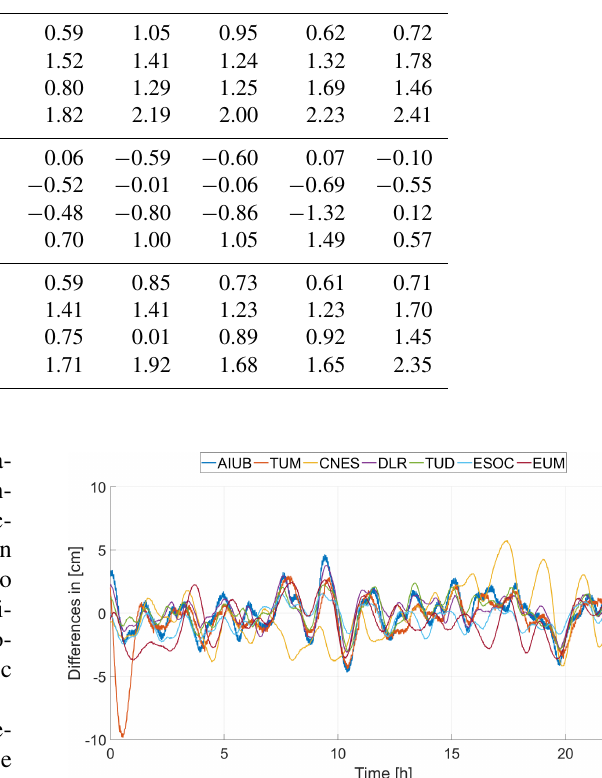
Table 2. Orbit comparison in the local orbital frame, CPOD vs. other solutions, no Helmert transformation applied, average of daily values. [cm]